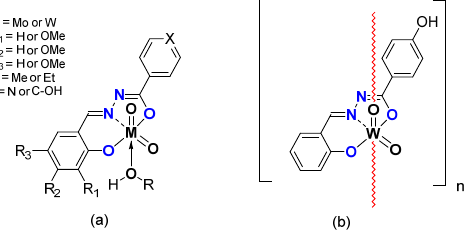
Figure 7. Schematic representation of neutral monomeric ( a ) and polymeric ( b ) Mo and Wspecies studied containing the salicylaldehydato fragment in the hydrazonato ligand.